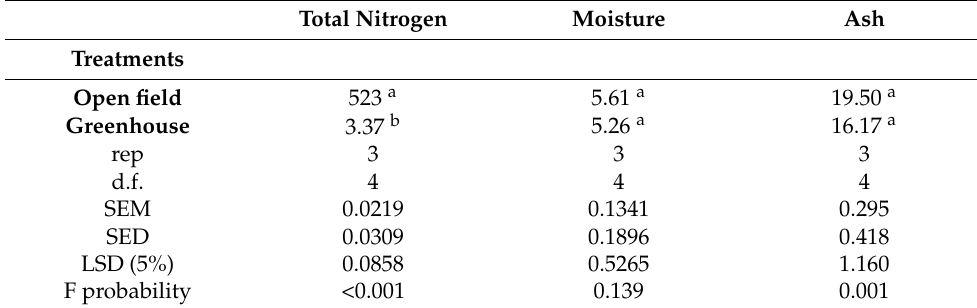
Figure 3. A comparative diagram showing the differences in proximate composition of A. Graecizans L. under open field (blue) versus greenhouse (orange) conditions a referrer to open field whilst b referrers to greenhouse. Table 4. Proximate composition of A. Cruentus L. in the open field vs. greenhouse on a dry weight basis (%).